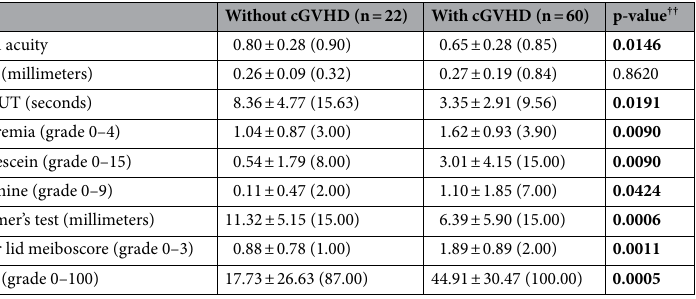
Table 2. Ocular assessment after hematopoietic stem cell transplantation. Data expressed in mean ± standard deviation (median). † Chi-square test; †† Mann–Whitney test; DED: Dry eye disease; cGVHD: Chronic Graft- versus-host disease; TMH: Tear meniscus Height; OD: right eye; OS: left eye; OSDI: Ocular Surface Disease Index. Significant values are in